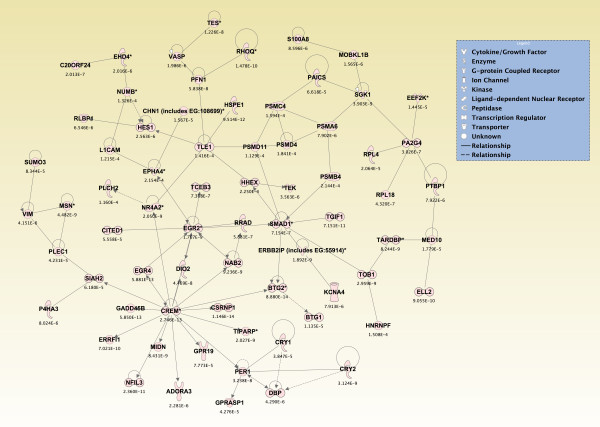
Seizure-induced alteration of behavior, nervous system development/function, and cellular growth/proliferation gene network.